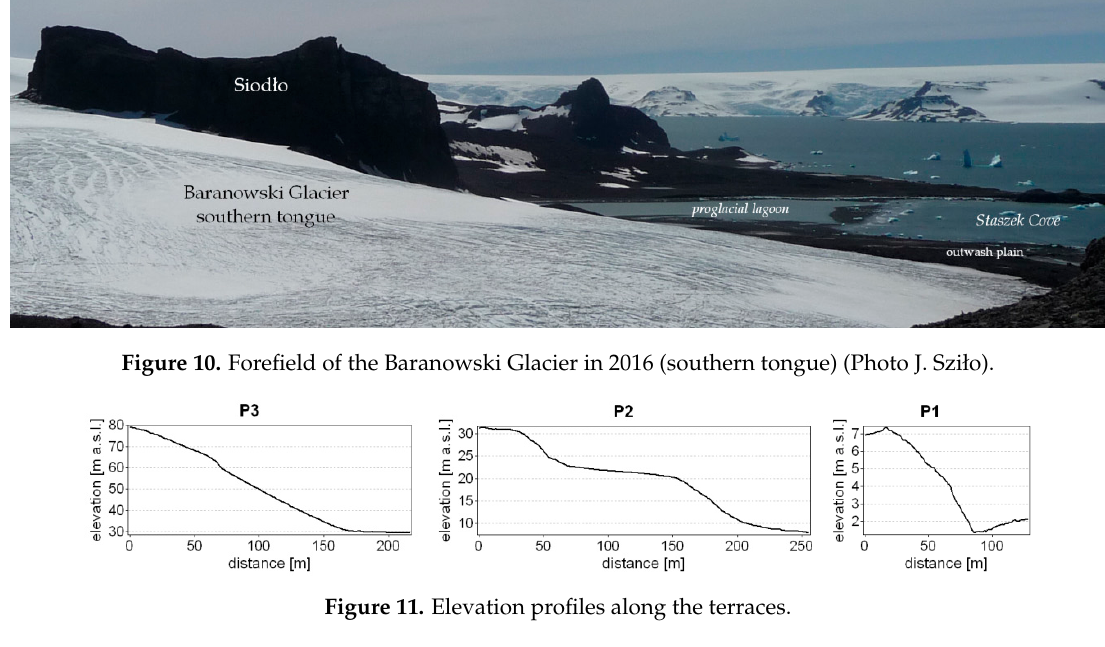
Figure 11. Elevation profiles along the terraces.